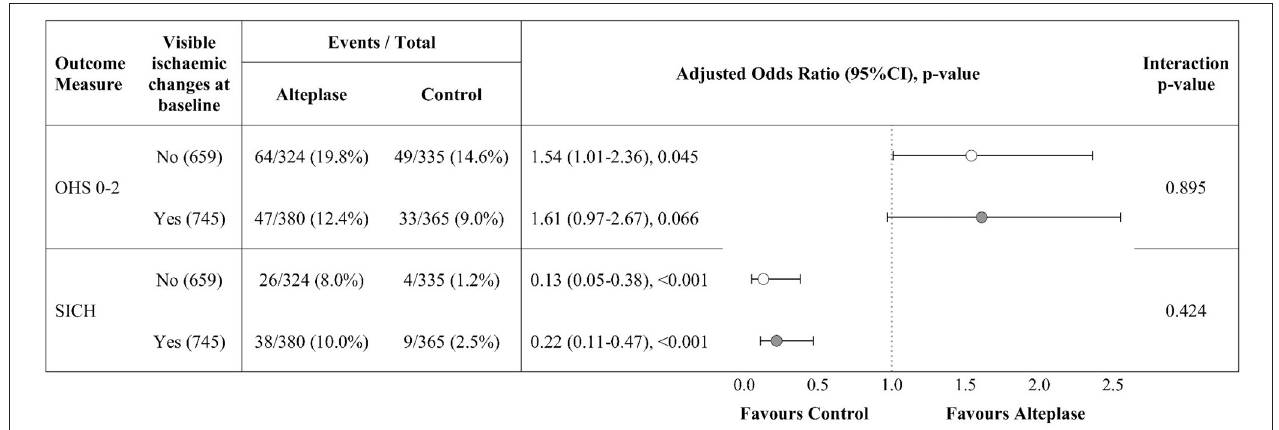
FIGURE 3 | Alteplase effect on outcome for subgroup patients (NIHSS > 11) with and without visible ischaemic brain changes on baseline CT, n = 1,404. Odds ratios are adjusted for age, NIHSS, time between stroke onset and CT scan. Open circles represent patients with NAIBT, closed circles without NAIBT. NIHSS, National Institutes of Health Stroke Scale; OHS, Oxford Handicap Scale at 6 months; SICH, Symptomatic Intracerebral Hemorrhage; NAIBT, Normal appearing ischaemic brain tissue.